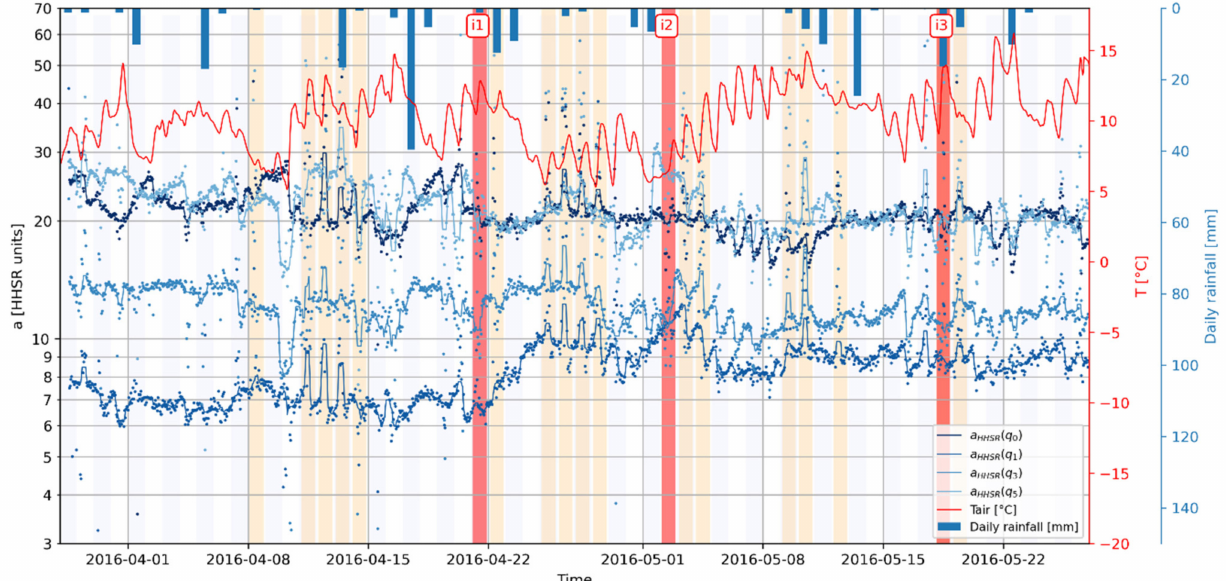
Figure 9. HHSR amplitude of peaks q 0 – q 5 with time (logscale on Y-axis). Continuous lines show the rolling median computed on 12 h long windows. Air temperature on-site is shown as red curve, and daily rainfall is shown as blue bars (downwards axis). Reinforcement work stages are shown in the background: drilling days (light orange) and grout injection